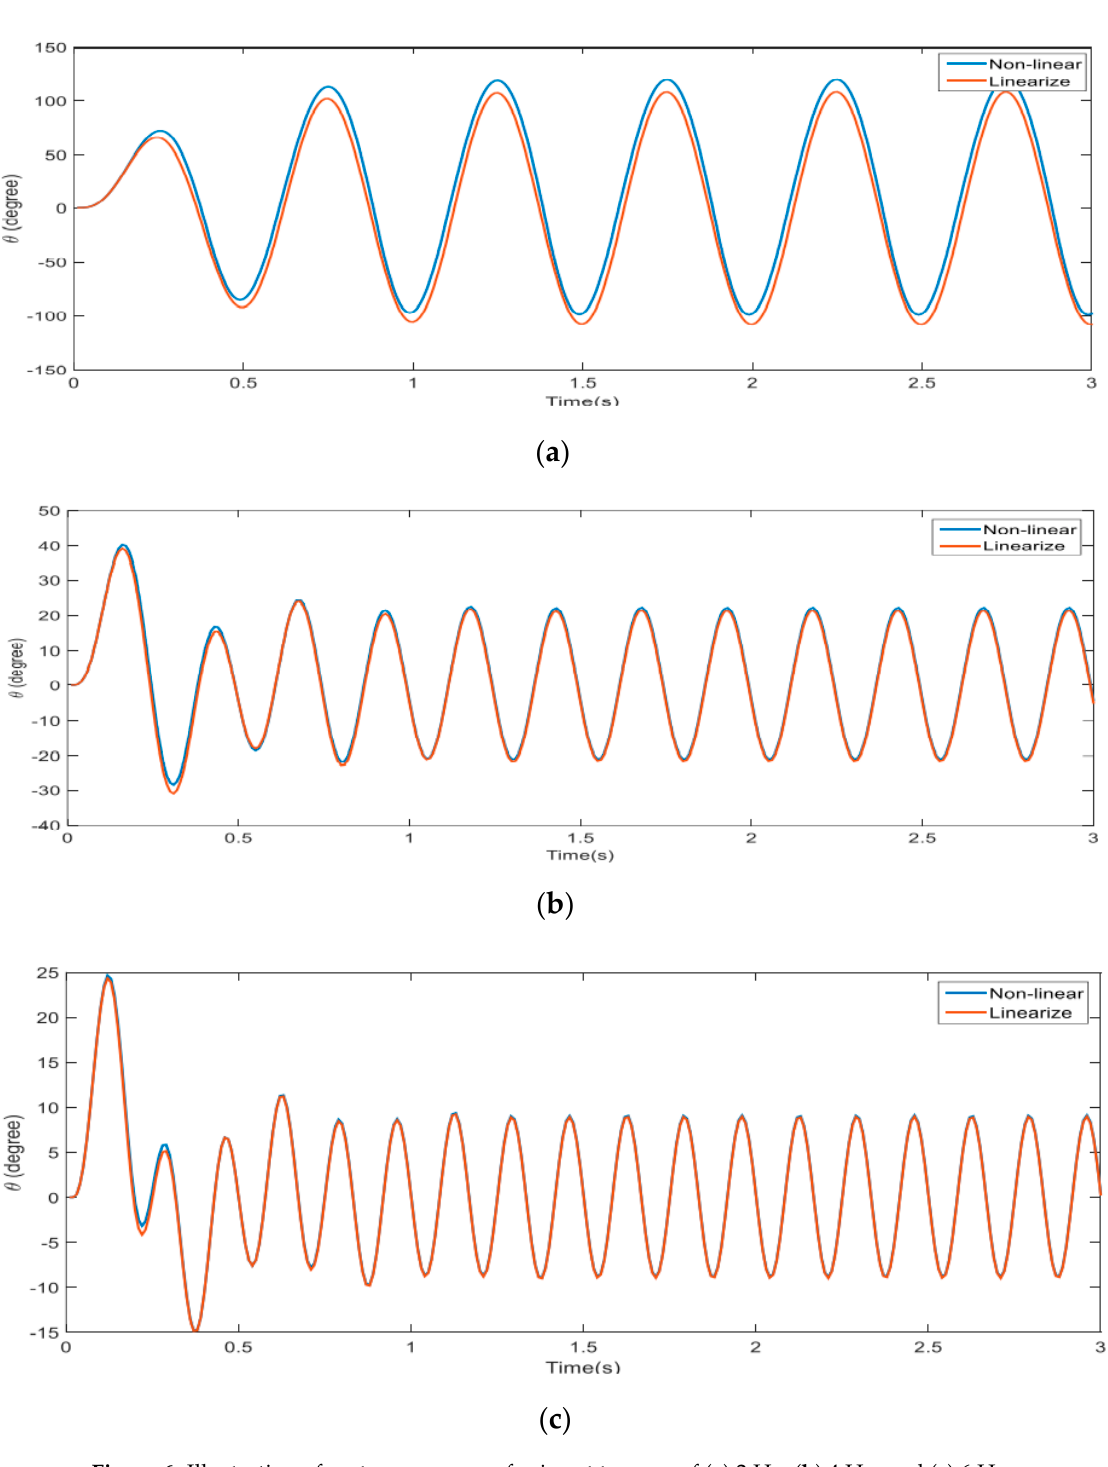
Figure 6. Illustration of system responses for input torques of ( a ) 2 Hz, ( b ) 4 Hz, and ( c ) 6 Hz. From the above modeling and analysis, we were motivated to carry out a feasible and innovative design. Due to the wearable characteristic, the structure must be compact and lightweight to ensure the comfort of the patient, as shown in Figure 7. The direct connection from the flywheel to the motor gives assistance to lessen the total weight of the device. The shape of the flywheel must be symmetrical, and its material should be distributed uniformly. Later, the driving motor type might be brushless DC, since it rapidly rotates around the radial axis. Both the flywheel and motor are linked to the internal